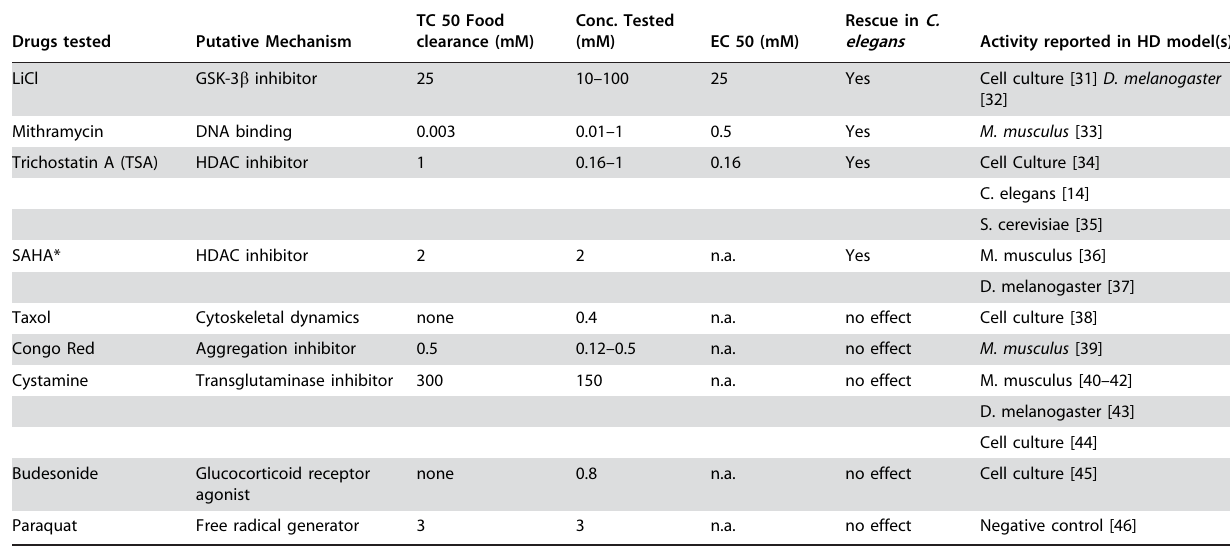
Table 1. Compounds screened in C. elegans polyQ model for neuroprotection. .. ... .... ... ... .... ... ... .... ... ... .... ... ... .... ... ... .... ... ... .... ... ... .... ... ... .... ... ... .... ... ... .... ... ... .... ... ... .... ... ... .... ... ... . Drugs